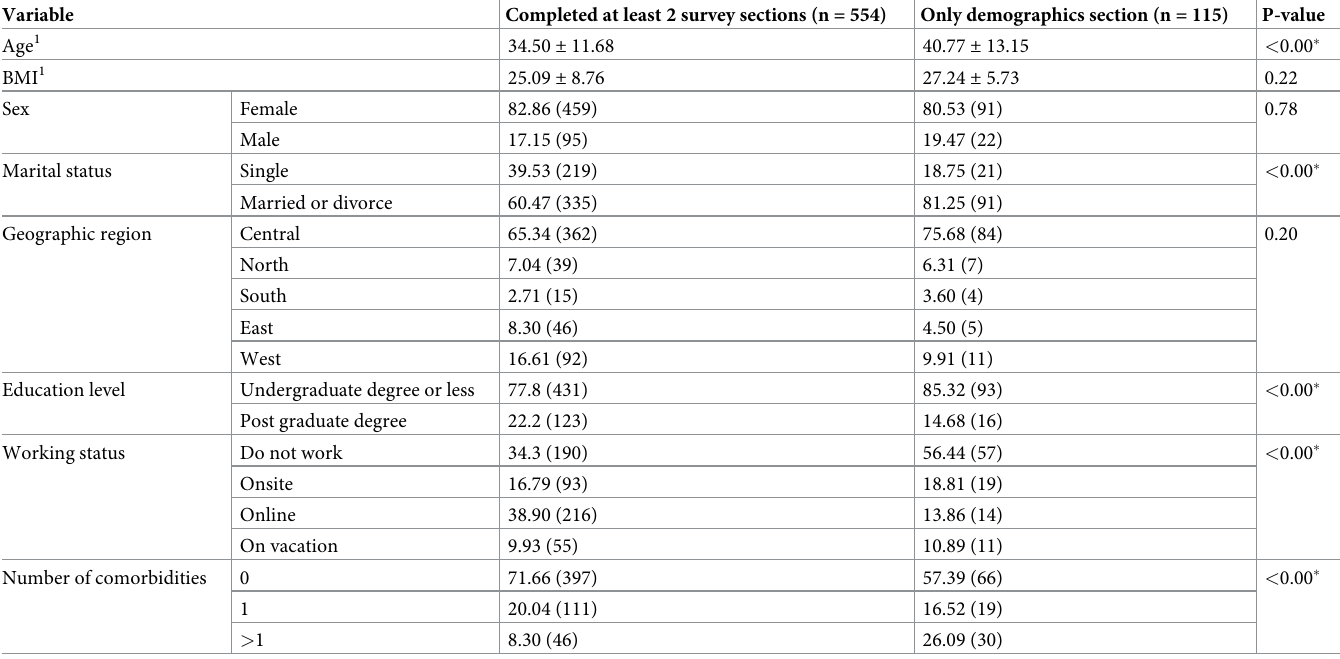
Data compared using chi-square test except for age and BMI where data were compared using student’s t -test 1 . Data reported as mean ± SD or Frequency (n). � Significant at p <